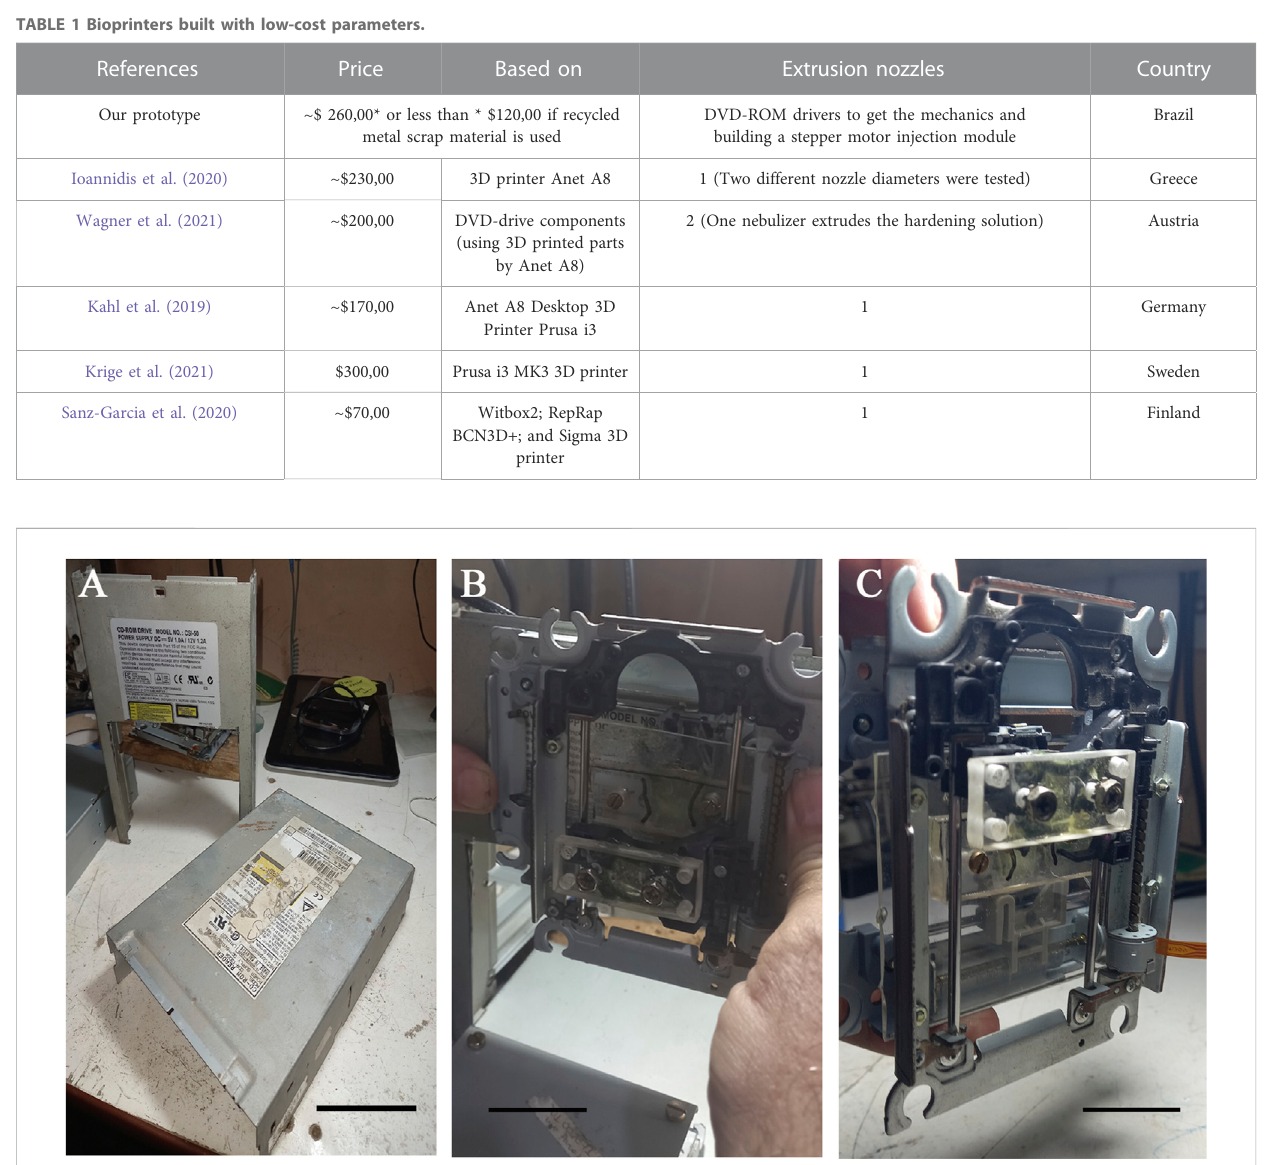
FIGURE 3 Mechanicalsetupoftheaxesinthe3Dmovementblock. (A) SteelcoverplatesfromCD-ROMboxesusedtopreparethemain3Dprinterstructure.A windowwascutintheverticalplatetoallowfortheY-axismovement.Scalebar:5 cm. (B) SetupoftheX-axisblockintheupperpartsoftheverticalplate. An acrylic plate rectangle was glued onto the optical block support of the X-axis to attach the Z block. Scale bar: 5 cm. (C) Setup of the Z-axis block with the rectangular acrylic plate glued onto the optical block support of the Z-axis with screws used to attach the needle support. Scale bar: 3